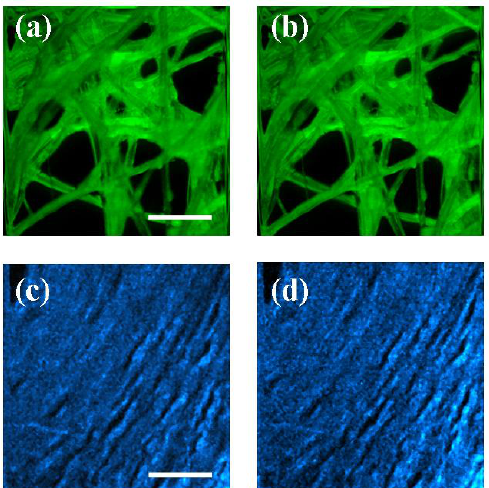
Figure 9. TPEF (top panels, piece of cellulose) and SHG (bottom panels, rabbit cornea) images corresponding to the best combinations of SA+axicon when optimizing acutance ( a , c ) and entropy ( b , d ). Bar length: 50 µ m. These images are very similar to those obtained when optimizing the signal, and depicted in Figures 5d and 8 (top right